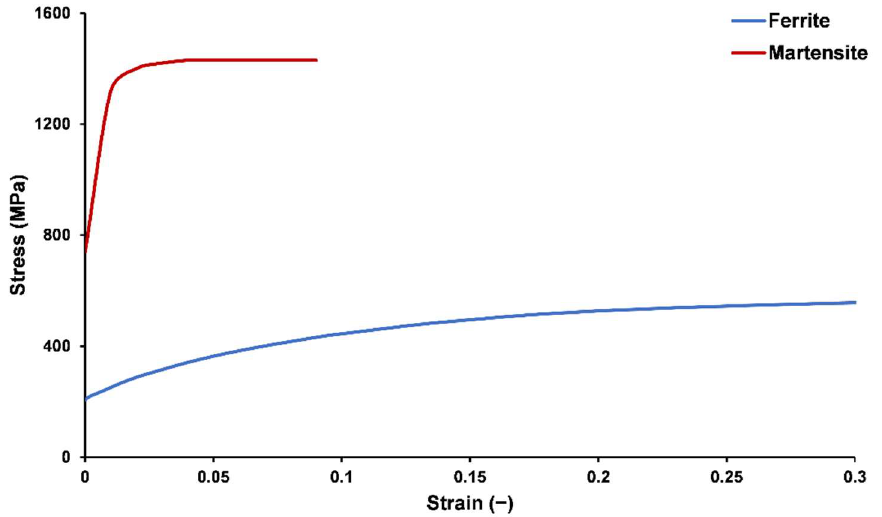
Figure 4. Flow curves of the ferrite and martensite phases used in micromechanical FEA [2].